Question: Name the type of graph shown.
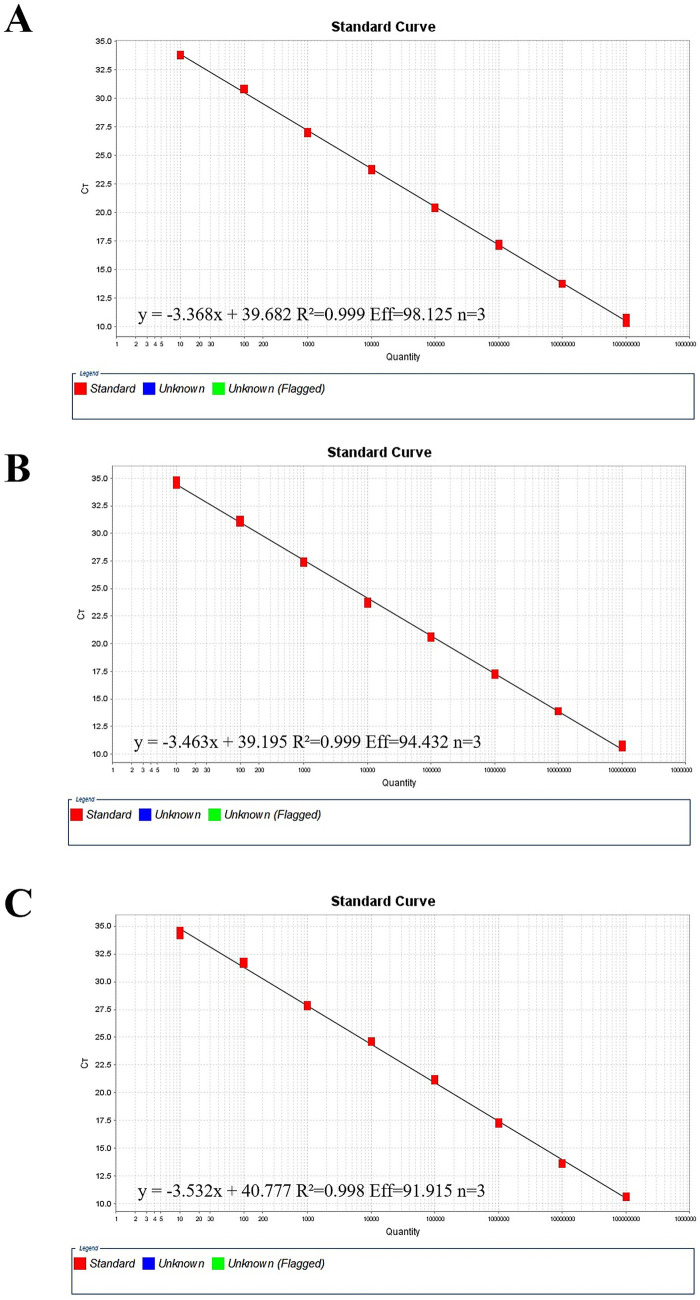
Answer: line